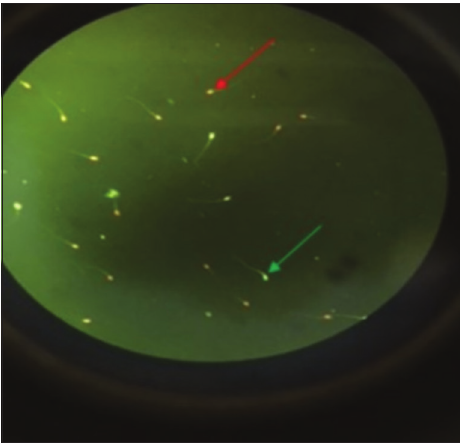
Figure-1: Live sperms appear green (green arrow) and dead appear in red (red